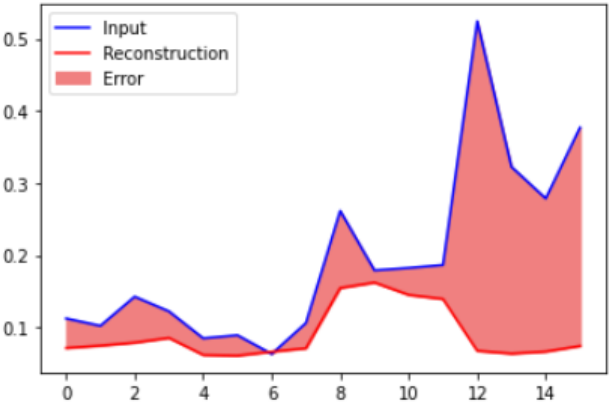
Figure 14. Reconstruction loss of anomalous data samples.